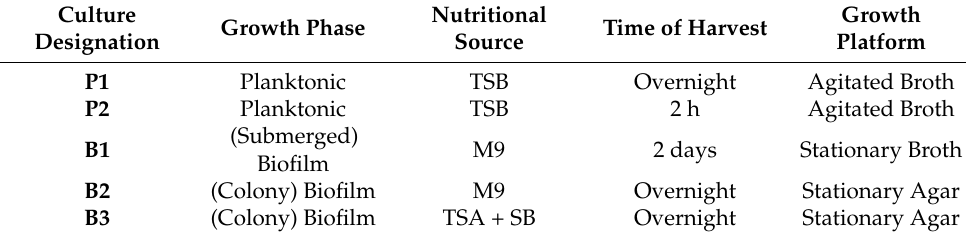
Table 1. AB5075 growth conditions and sample